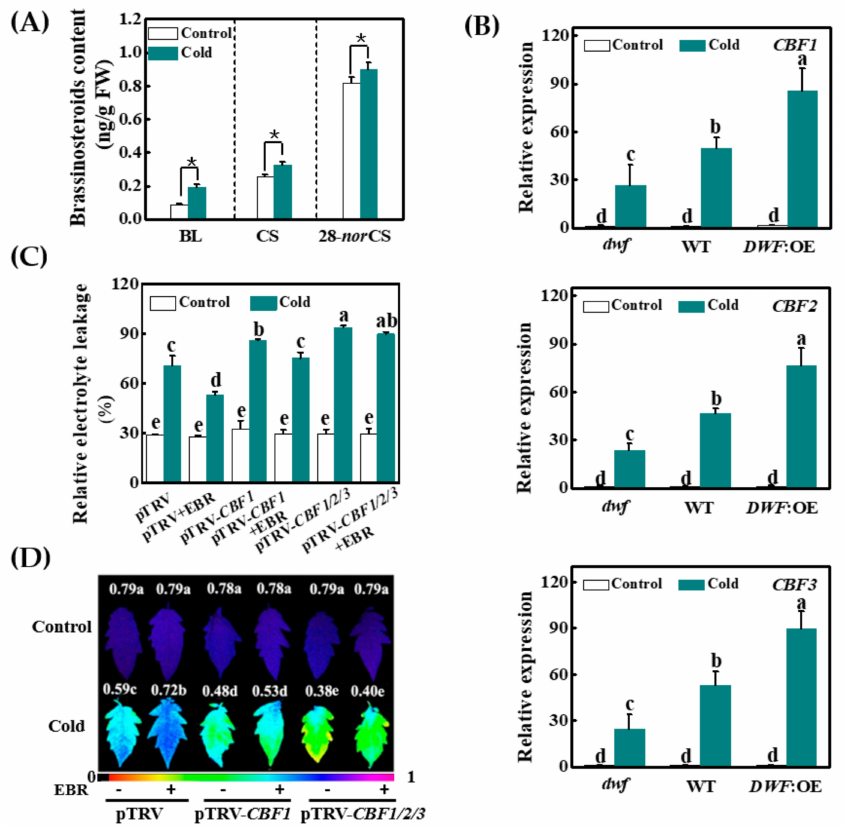
Figure 1. Cold-induced brassinosteroid (BR) regulated cold tolerance via c-repeat binding factor (CBF)-dependent pathway in tomato. ( A ) Cold-induced brassinosteroid accumulation. Brassinos- teroid contents in tomato leaves after exposure to 25 ◦ C (Control) and 8 ◦ C (Cold) for 8 h. BL, brassinolide; CS, castasterone; 28- nor CS, 28- nor castasterone. * indicates significant differences accord- ing to T -test at 0.05% level.( B ) The relative expression levels of CBF genes in dwf mutant, wild-type (WT), and DWARF -overexpressing transgenic plants ( DWF :OE) after exposure to 25 ◦ C (Control) or 8 ◦ C (Cold) for 8 h. ( C ) The relative electrolyte leakage (REL) and ( D ) the maximum quan- tum efficiency of photosystem II ( Fv / Fm ) in the control (pTRV), CBF1 -silenced (pTRV- CBF1 ), and CBF1 / 2 / 3 -co-silenced (pTRV- CBF1 / 2 / 3 ) plants with and without exogenous BR. For cold treatment, plants were exposed to 8 ◦ C for 24 h and subsequently exposed to 4 ◦ C for another six days. For the exogenous BR treatment, the plants were foliar applied with 200 nM EBR 24 h before cold treatment. Plants sprayed with distilled water were used as the control. Data are the means of three biologi- cal replicates ( ± SD) ( A – C ) or eight replicates ( D ). Different letters indicate significant differences according to Tukey’s test at 0.05%